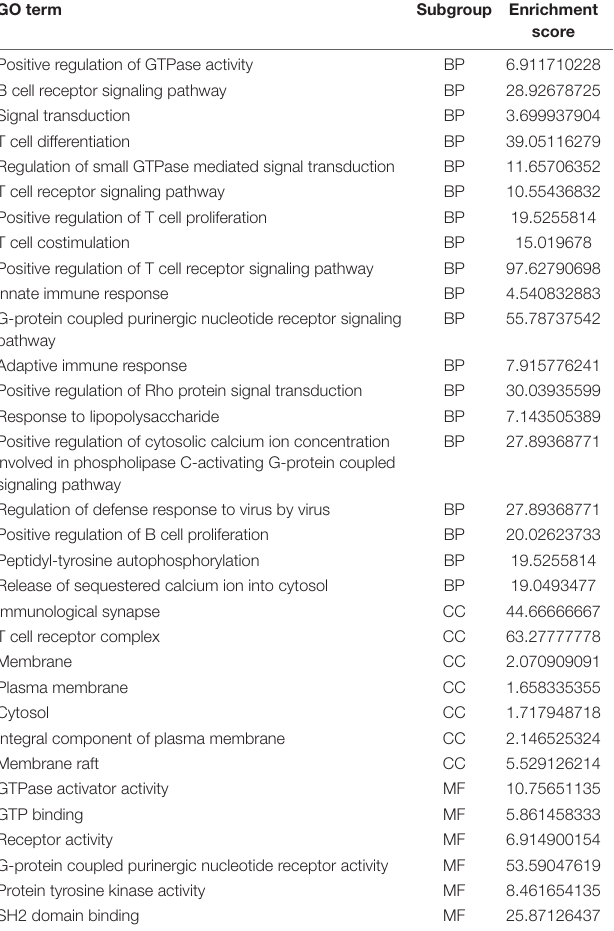
TABLE 2 | The BP, CC, and MF were showed specifically of 49 immune related genes.